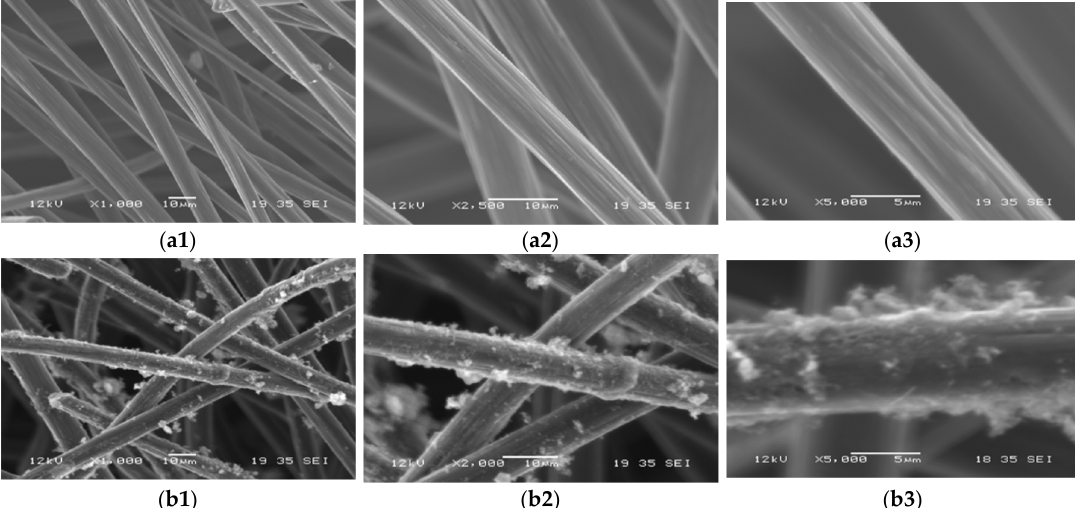
Figure 3. Comparison of SEM images of untreated carbon felts (top) ( a1 ) is a 1000 magnification image of untreated carbon fiber, ( a2 ) is a 2500 magnification image, and ( a3 ) is a 5000 magnification image, and treated carbon felts (bottom). ( b1 ) 1000 magnification image of carbon fiber after processing, ( b2 ) 2000 magnification image, and ( b3 ) 5000 magnification image.